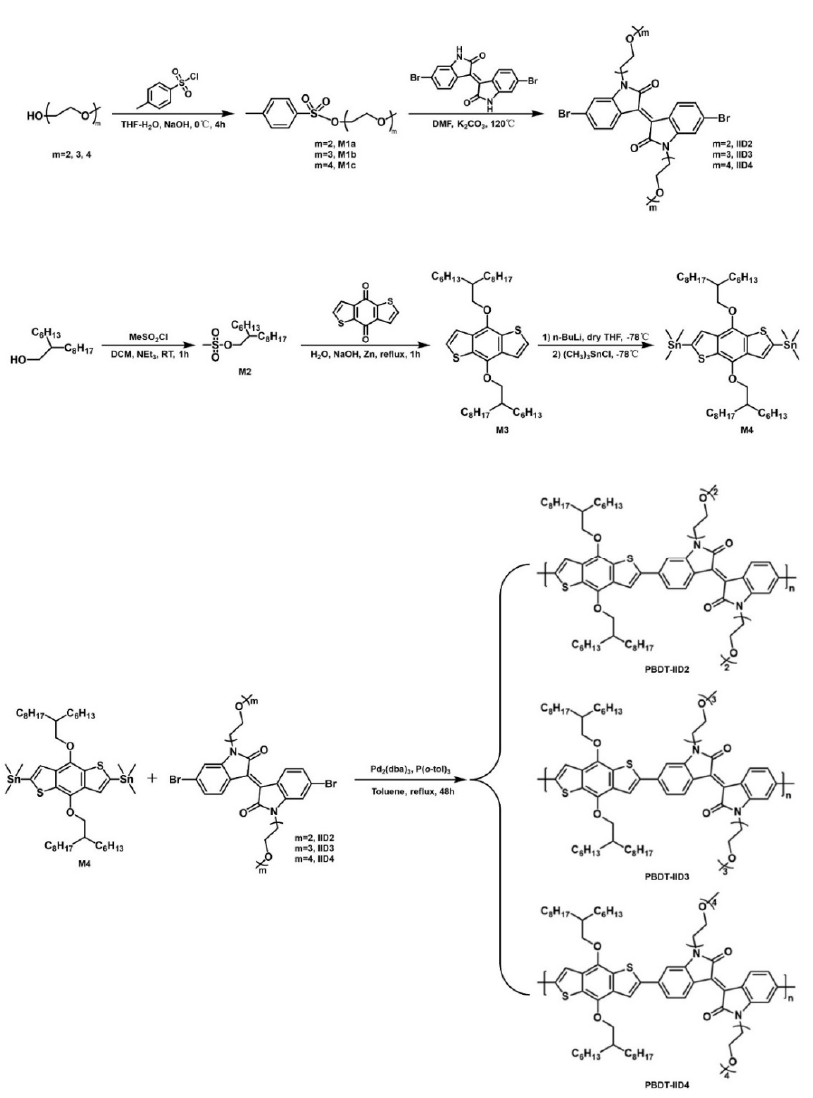
Figure 1. The chemical structure diagrams of PBDT-IID2, PBDT-IID3, and PBDT-IID4.